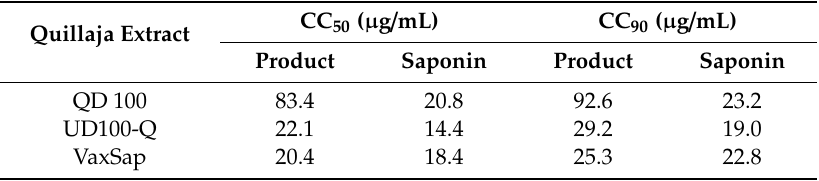
Table 1. Cytotoxicity (CC 50 and CC 90 ) of quillaja extracts on SHK-1 cell culture.